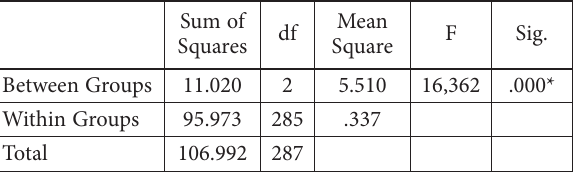
Table 4. Analysis of variance of pH values in the experiments with different filtration materials Mean Sum of df Square Squares